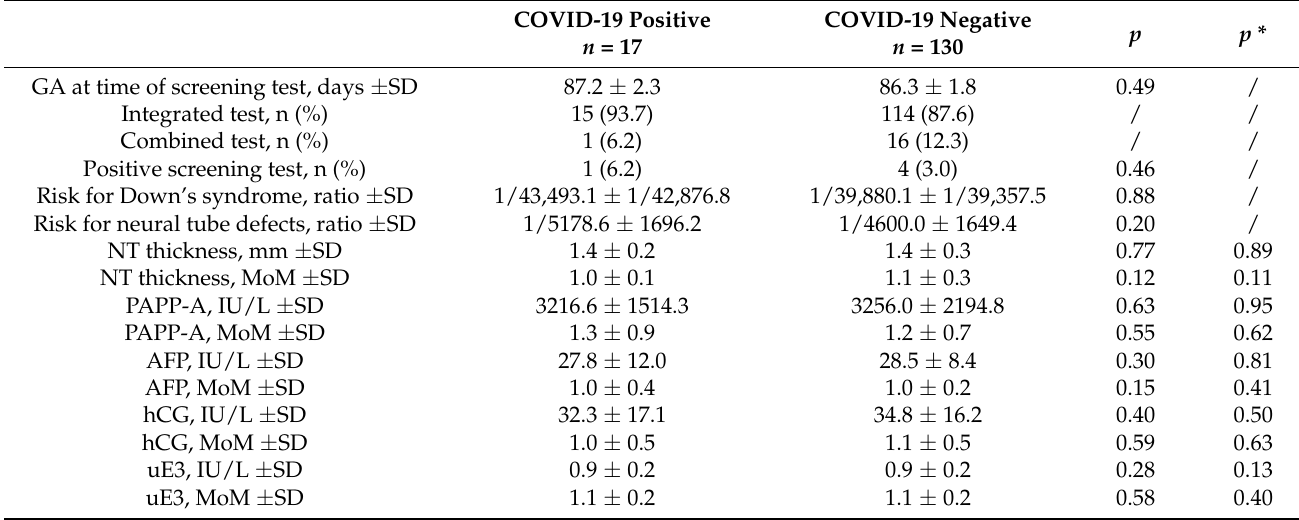
Table 2. Noninvasive prenatal screening test findings in COVID-19-positive and -negative patients. COVID-19